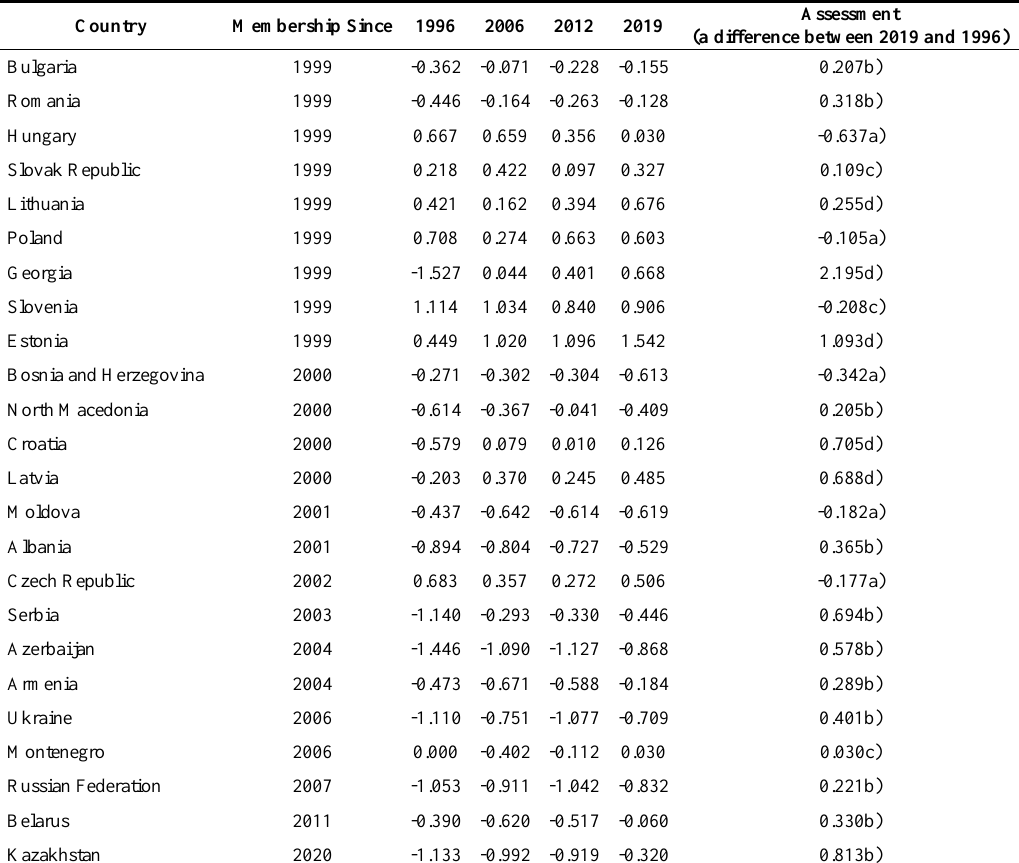
Table 1. The performance score in the Control of Corruption (Worldwide Governance Indicators), the GRECO group East,